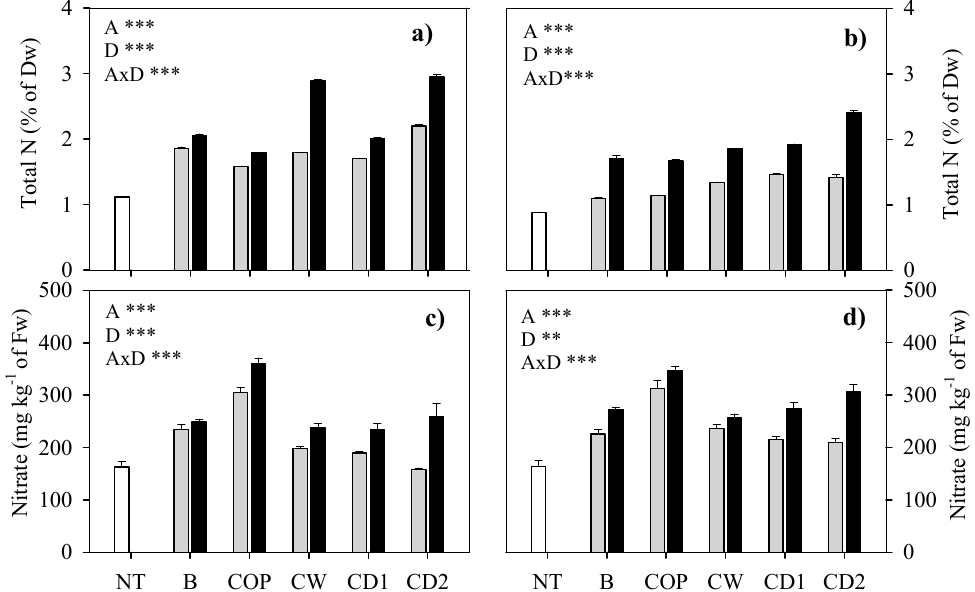
Figure 3. Total nitrogen ( a , b ) and nitrate content ( c , d ) of Swiss chard treated with di ff erent organic amendments (B, biochar; COP, compost from olive pomace; CW, vermicompost from cattle manure; CD1, compost from 90% cattle anaerobic digestate with 10% wheat straw addition; CD2, compost from 79% cattle anaerobic digestate with 11% crop residues and 10% wheat straw addition), each added to provide 140 and 280 of kg N / ha, (grey and black bars, respectively), plus a non-treated soil or control (NT, white bar). The graphs on the left refer to the first leaf cut ( a , c ) while on the right to the second cut ( b , d ). Values are means (n = 4) ± standard errors. Data in each graph were analyzed by two-way ANOVA followed by Duncan test at p ≤ 0.05. A, amendment; D, dose; **, p ≤ 0.01; ***, p ≤ 0.001.